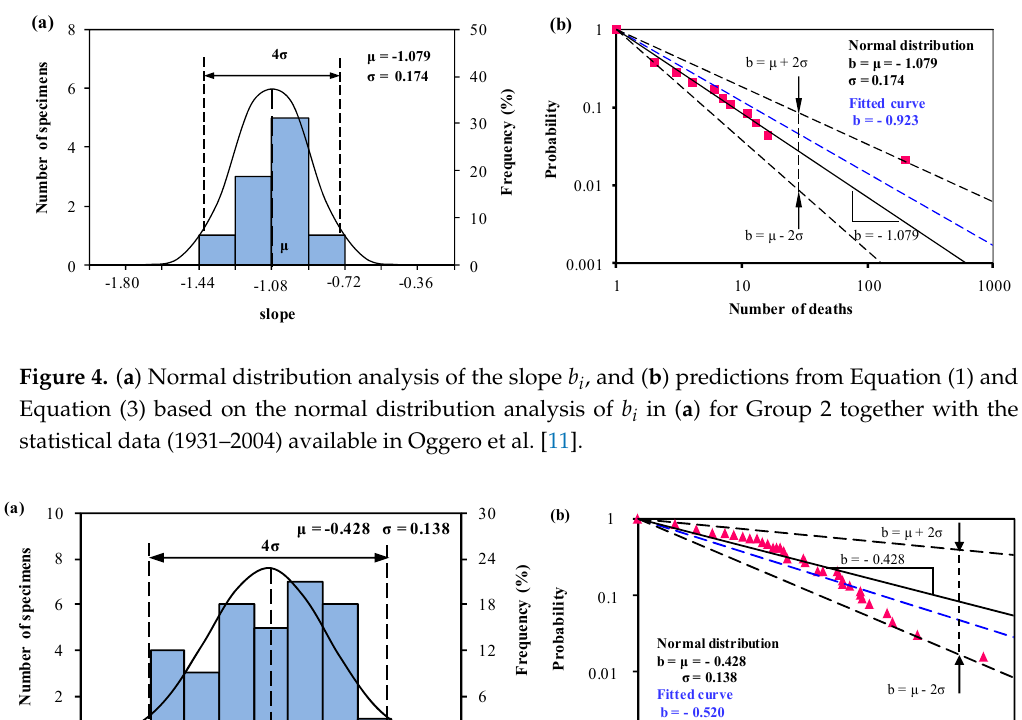
Figure 4. ( a ) Normal distribution analysis of the slope b i , and ( b ) predictions from Equation (1) and Equation (3) based on the normal distribution analysis of b i in ( a ) for Group 2 together with the statistical data (1931–2004) available in Oggero et al. [11].